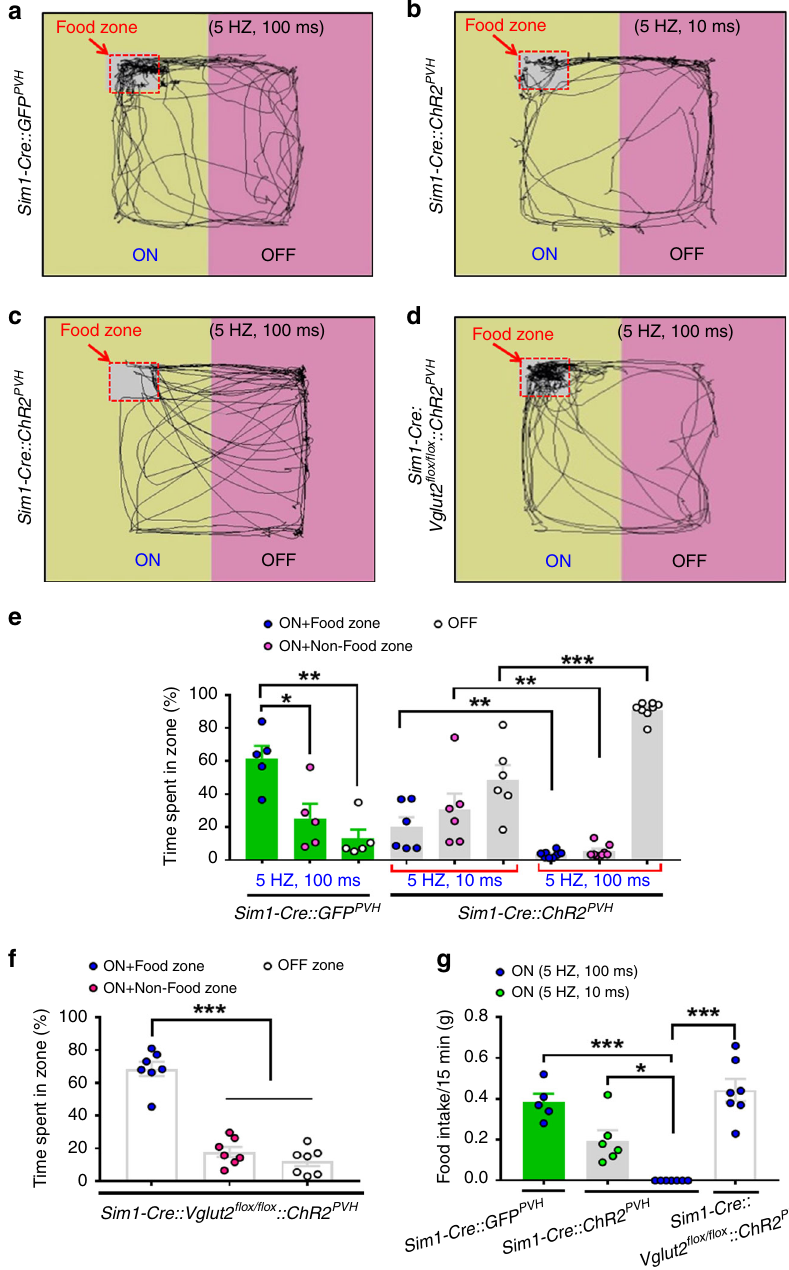
Fig. 6 Place aversion by photostimulation of PVH → LSv terminals antagonizes hunger-driven feeding. Male mice with AAV-Flex-ChR2-eGFP delivery to PVH and optic fi ber implantation targeting LSv were fasted 12 hr before RTPP tests, in which chow diet pellets were placed in the corner of the side paired with photostimulation PVH → LSv fi bers a – d . Representative movement traces were shown for Sim1-Cre control mice with AAV-Flex-GFP injection a , Sim1- Cre mice with short pulse (ON,10 ms, 5 Hz, 5 mW/mm 2 , b , long pulse photostimulation (ON,100 ms, 5 Hz, 5 mW/mm 2 , c ) and for Sim1-Cre::Vglut2 fl ox/ fl ox mice with long pulse photostimulation (ON, d ). e – g Time spent in zones in Sim1-Cre mice with AAV-Flex-GFP delivery ( e , n = 5; On + Food zone vs On + Non-food zone, p = 0.0126; On + Food zone vs OFF zone, p = 0.0016) or with AAV-Flex-ChR2-eGFP delivery, and Sim1-Cre::Vglut2 fl ox/ fl ox mice with AAV-Flex-ChR2-eGFP delivery ( f , n = 7; On + Food zone vs On + Non-food zone or OFF zone, p < 0.0001). g Food intake was measured during a 15 min testing period in d – f , n = 5 – 7/group (Sim1-Cre mice 5 HZ,10 ms vs 5 HZ,100 ms, p = 0.0130; all other comparisons, p < 0.0001). * p < 0.05, ** p < 0.01 and *** p < 0.001, one-way ( e , f , and g ) or two-way ( e ANOVA feeding (Fig. 6b – g), suggesting an inverse relationship between PVH → LSv terminals reduces feeding by orchestrating behaviors the level of aversion and hunger-driven feeding. In contrast, the related to negative emotion. same long pulse photostimulation did not alter food preference or fasting-refeeding responses in Sim1-Cre::Vglut2 fl ox/ fl ox mice (Fig. 6d, f, g), reinforcing the role for glutamate release in aversion Identity of PVH neurons that send projections to LSv . The and feeding inhibition. These results suggest that stimulation of PVH is composed of diverse and functionally distinct groups of